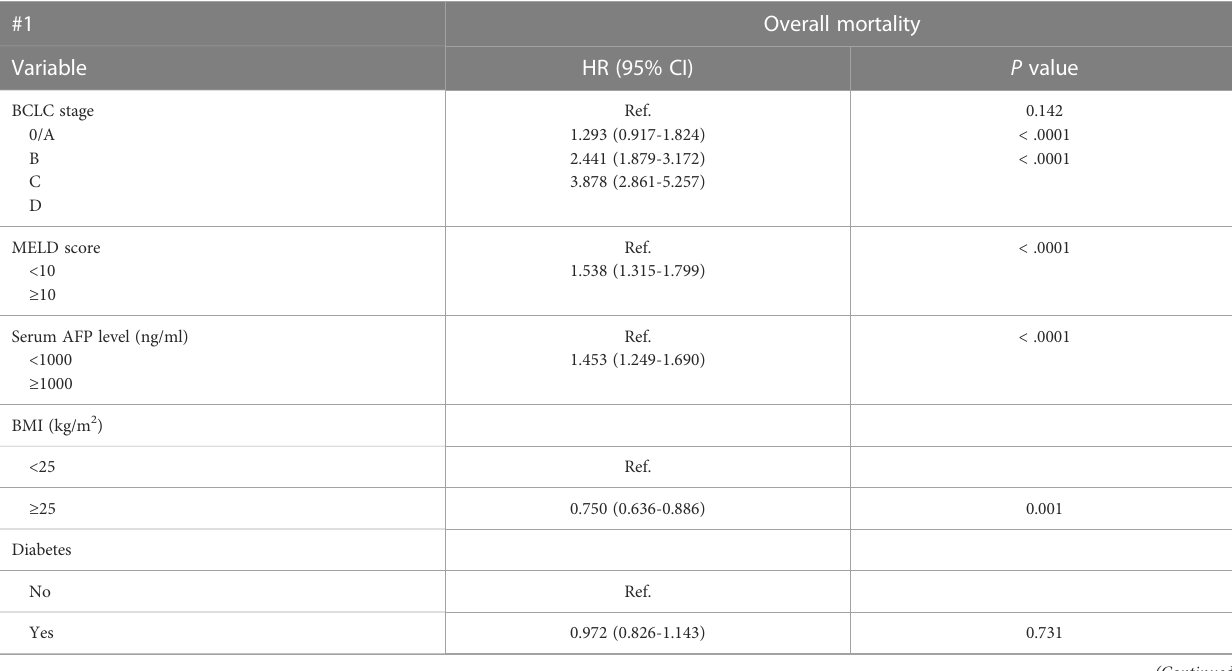
TABLE 4 Multivariate cox proportional hazards regression models of factors associated with mortality in 806 patients with untreated HCC with information on BMI and